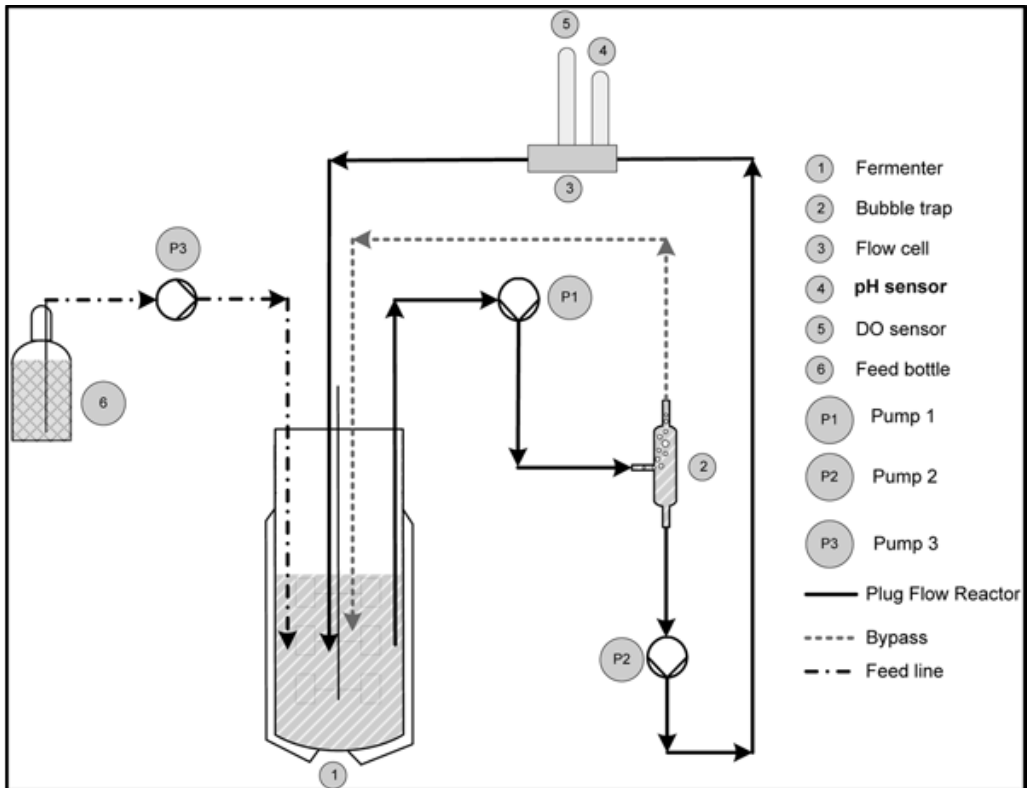
Figure A1. Schematic view of the two-compartment